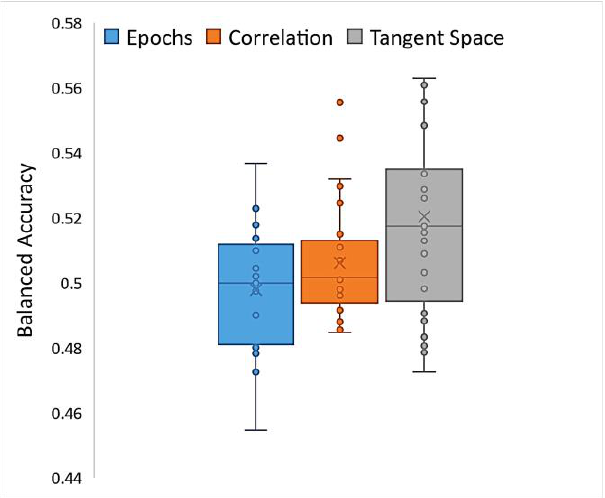
Figure 8. Box plot of balanced accuracies obtained while running HCBR with epoch vectors, corre- lation vectors, or correlation matrices projected into the tangent space. The mean (SD) balanced accuracy for the VQC and the QSVC was 51.83% (2.78%) and 50.25% (0.83%), respectively.